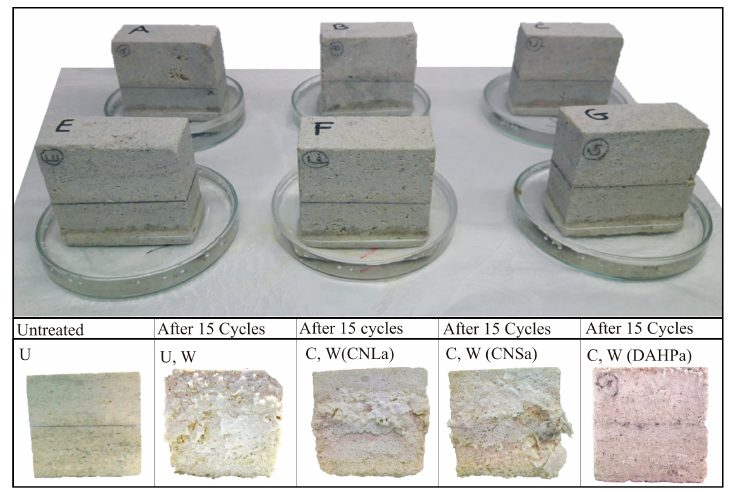
Figure 8. Salt weathering of some representative “San Lucido” stone specimens. Note: U, untreated; C, consolidated; W, weathered; CNL, CaLoSiL ® ; CNS, Nano Estel ® ; DAHP, Mixture of Ca(OH) 2 and diammonium hydrogen phosphate.